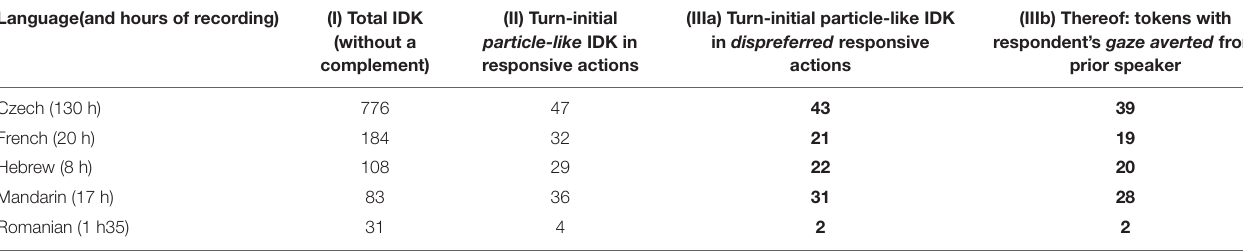
TABLE 2 | Overview of IDK tokens (without complement) occurring in the data from the five languages. Language(and hours of